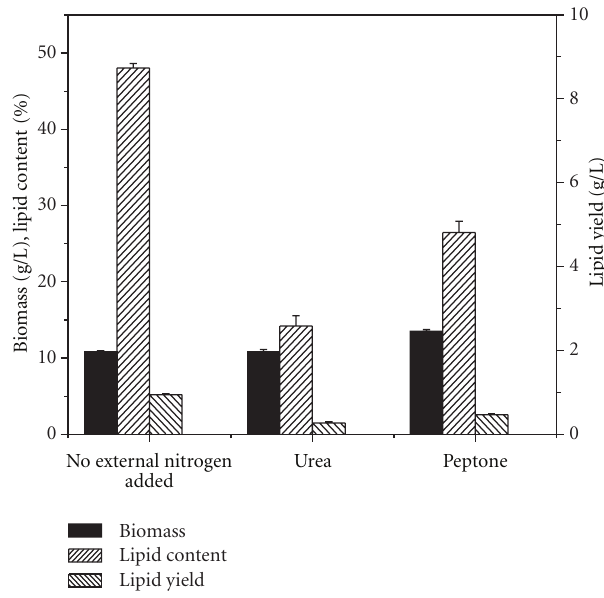
Figure 2: E ff ects of nitrogen addition on microbial oil production by Y. lipolytica Po1g grown in DRBH medium . Culture conditions: growth in Erlenmeyer flasks; initial total sugar concentration: 30g/L; pH: 6.5; incubation temperature: 26 ◦ C; agitation speed =